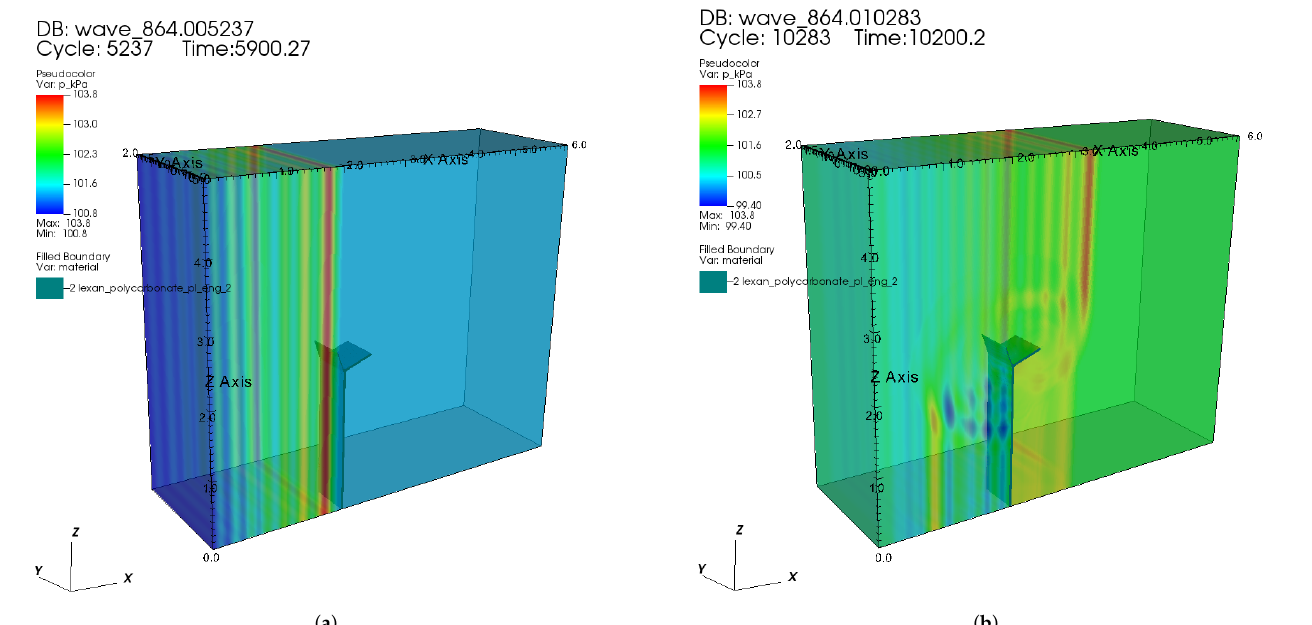
Figure 9. Images from a representative 3D blast-barrier mitigation simulation: ( a ) at arrival time of wave at barrier. ( b ) During dynamic interaction